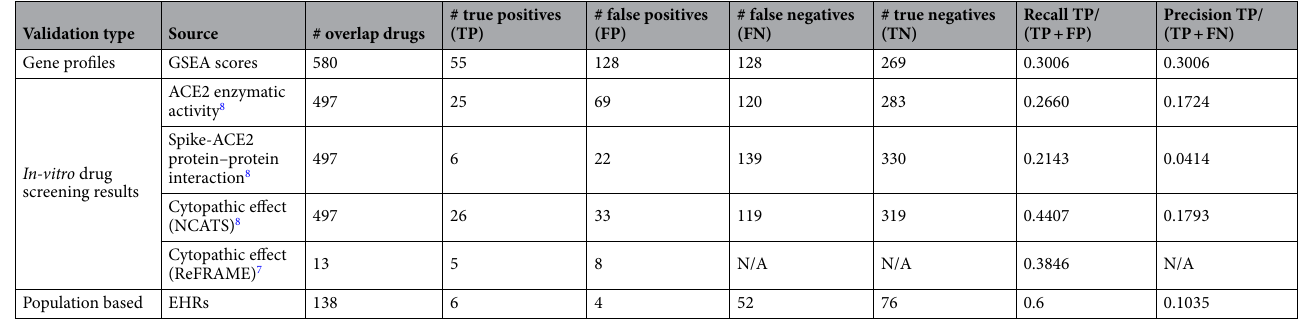
Table 2. External validation of the candidate drugs using in vitro drug screening results and EHRs. N/A not available. False-negative or true-negative values could not be obtained because the cytopathic effect (ReFRAME) study only reports positive drugs 7 . Caution is needed in interpreting the accuracy because the number of overlapping drugs is limited in some studies and, thus, the statistical power is